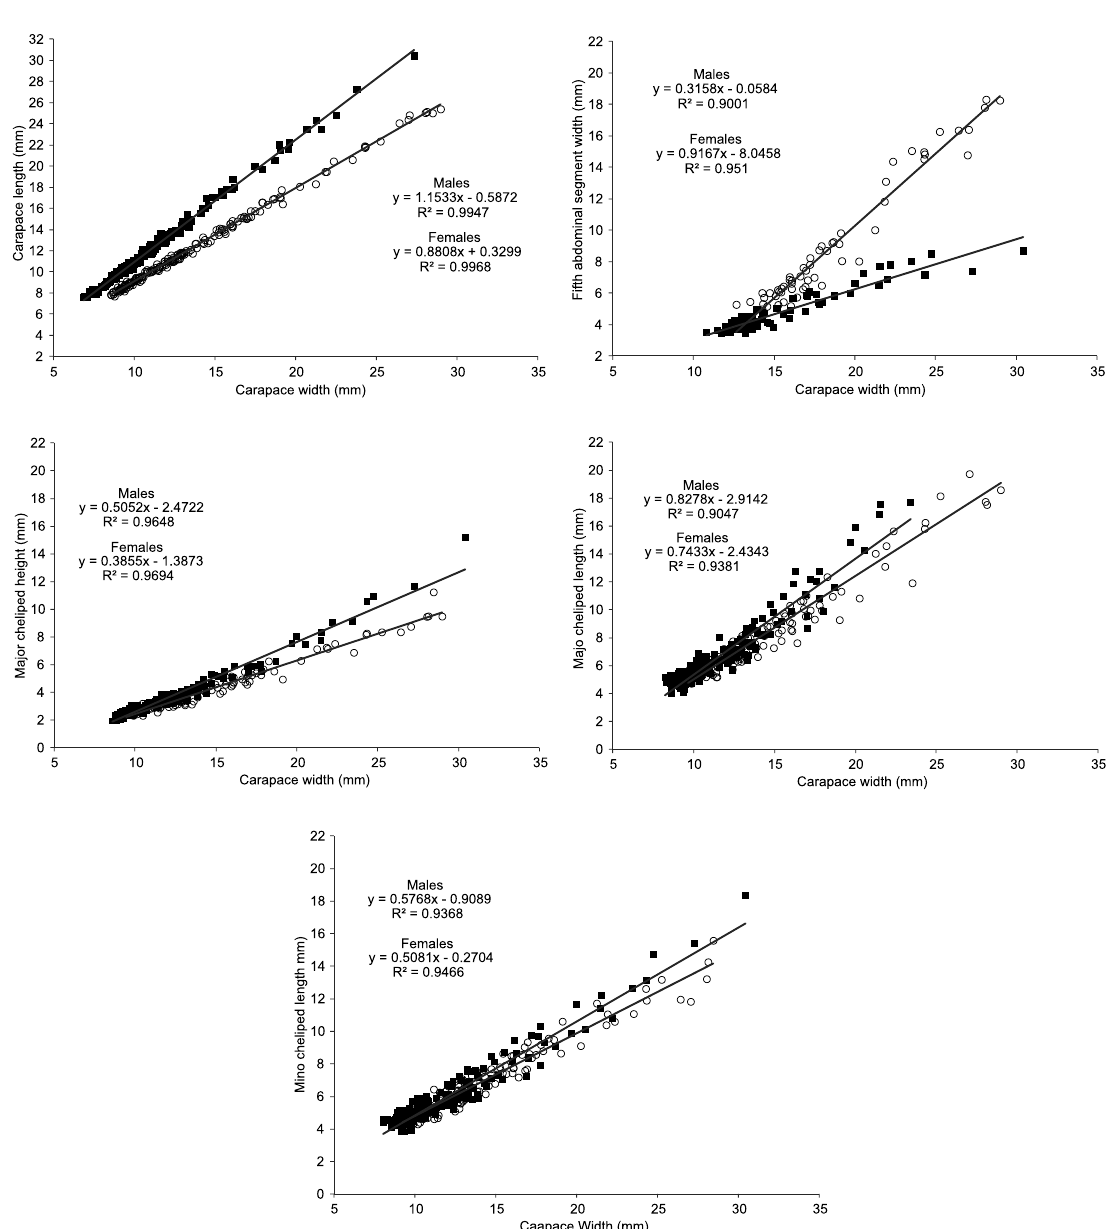
Figure 2. Trichodactylus fluviatilis . Sexual dimorphism in biometric relationships (non-linearized data). Solid quadrat, adult males; empty circle, adult